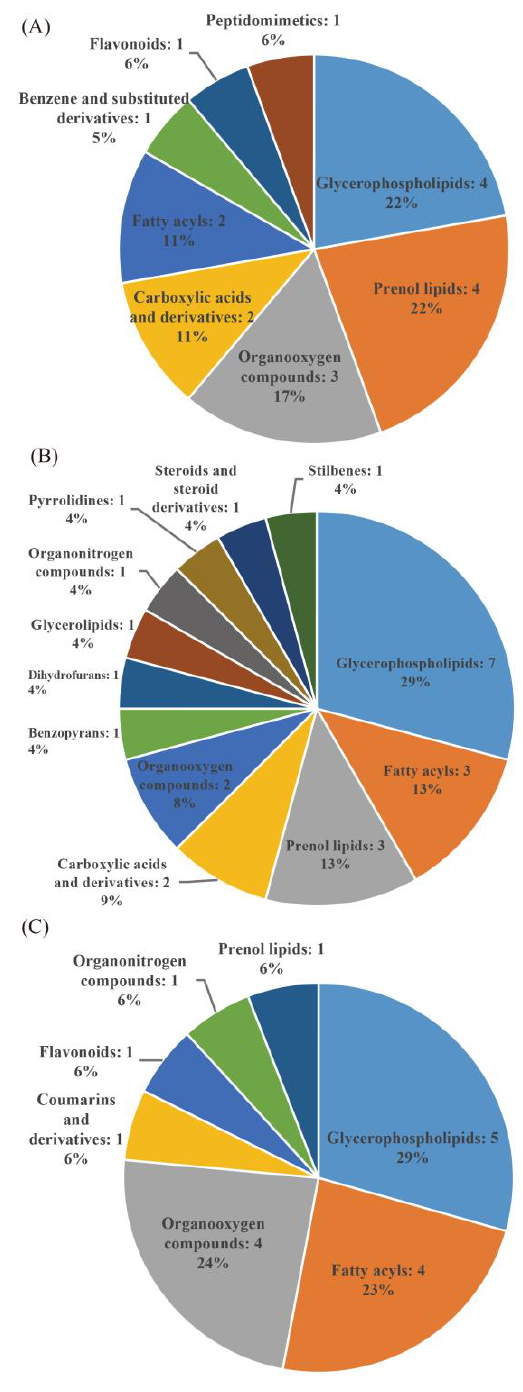
Figure 2. Classification statistics of compounds under different nitrogen fertilizer and density treatments: ( A ) HNLD and LNHD, ( B ) HNLD and MNMD, and ( C ) LNHD and MNMD. According to the number of metabolites, the name of the selected HMDB class (class) and the percentage of metabolites are displayed. The different colors in each pie chart in the figure represent different HMDB classifications, and their areas represent the relative proportion of metabolites in that